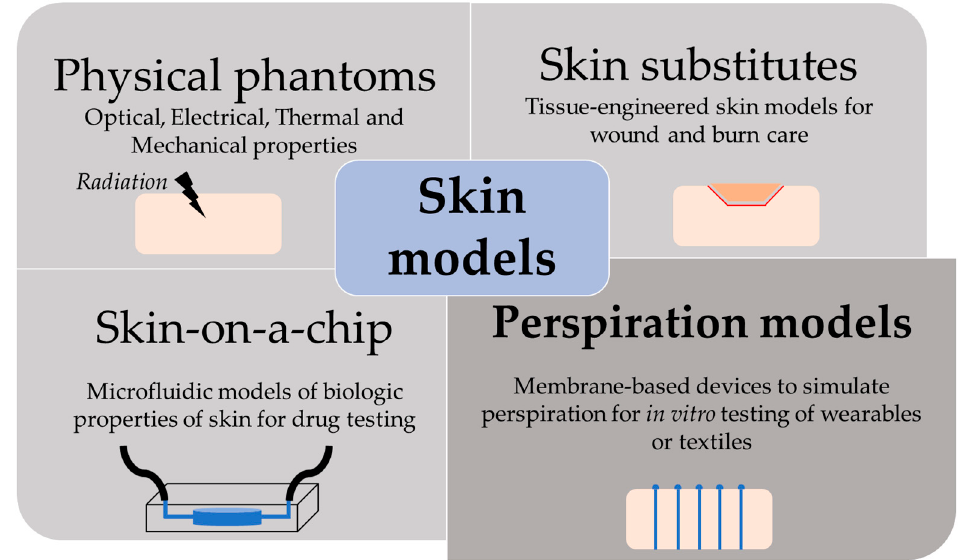
Figure 1. Scheme of the different purpose and applications of skin models.